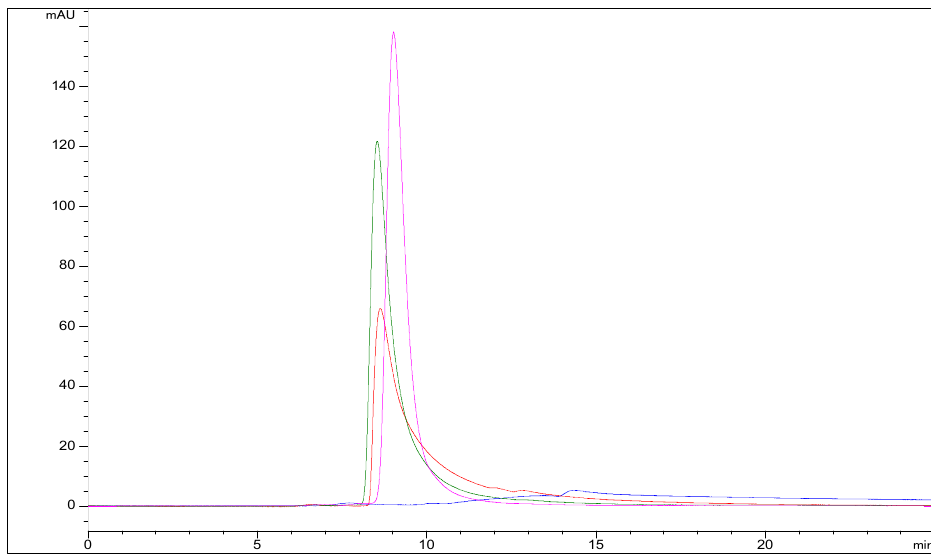
Figure A6. RP-HPLC chromatograms of Lf samples (optimized RP-HPLC method on a BioZen™ Intact XB-C8 column): −− control sample (thermal), −− thermal stress sample (T = 60 °C, t = 30 min), −− control sample (acidic and alkaline), −− acidic stress sample (0.1 M HCl, t = 3 days), and −− alka- line stress sample (0.01 M NaOH, t = 4 h).